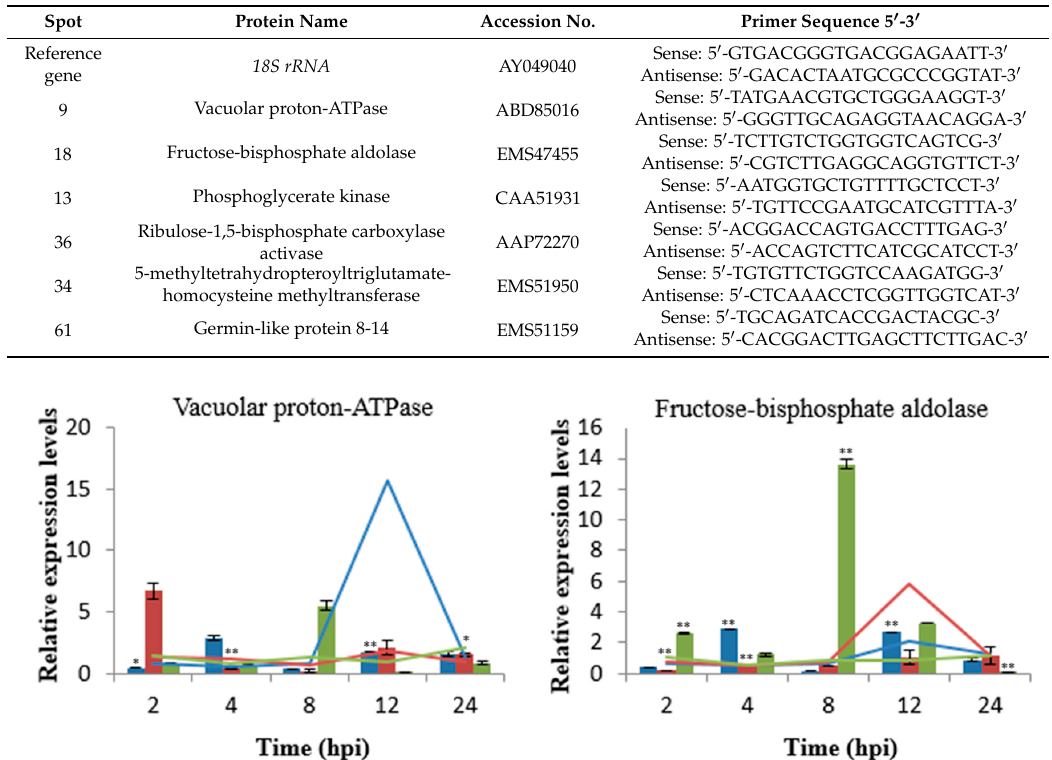
Table 2. List of primers used for qRT-PCR amplification.